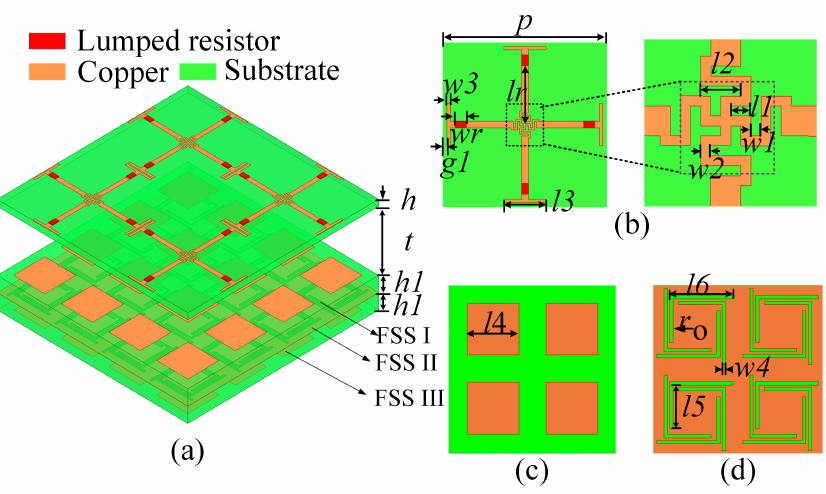
Figure 1. Topology and dimensions of the proposed FSR. ( a ) Overall FSR diagram. ( b ) Resistive layer. ( c ) FSS I and FSS III layer. ( d ) FSS II layer (h = 0.813 mm, t = 9 mm, h1 = 2 mm, l1 = 0.4 mm, l2 = 0.8 mm, l3 = 4.5 mm, l4 = 4.7 mm, l5 = 3.7 mm, l6 = 5.1 mm, w1 = 0.2 mm, w2 = 0.2 mm, w3 = 0.3 mm, w4 = 0.3 mm, g1 = 0.1 mm, lr = 4.8 mm, wr = 1 mm, r = 1.6